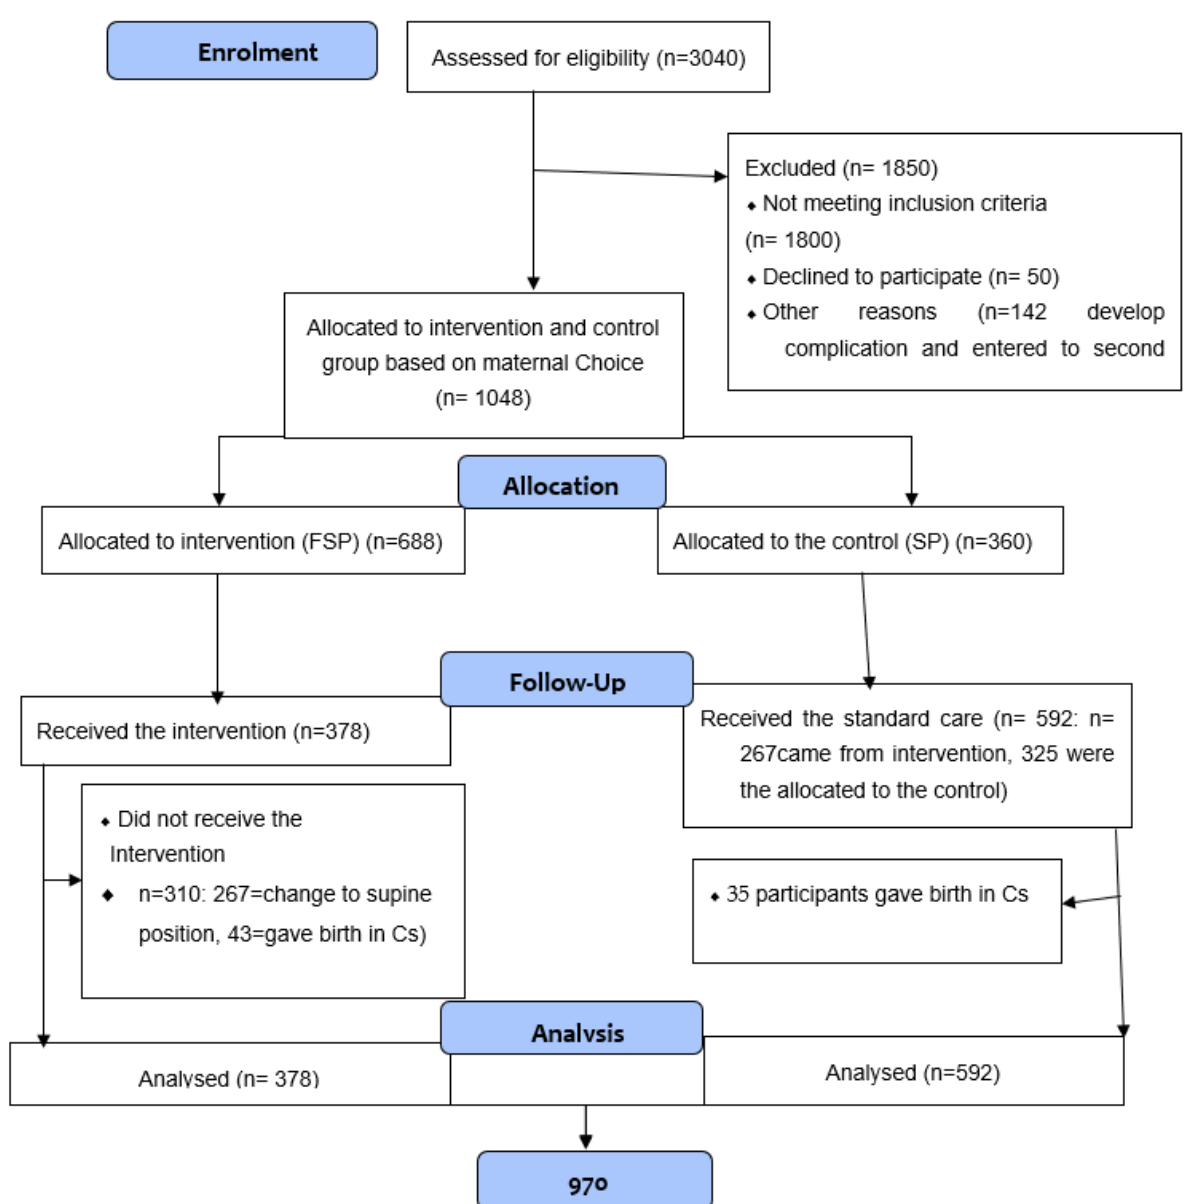
Figure 1. Flow diagram for participants’ recruitment, enrollment, follow-up, and analysis in the study in Amhara public Health facilities, 2019.